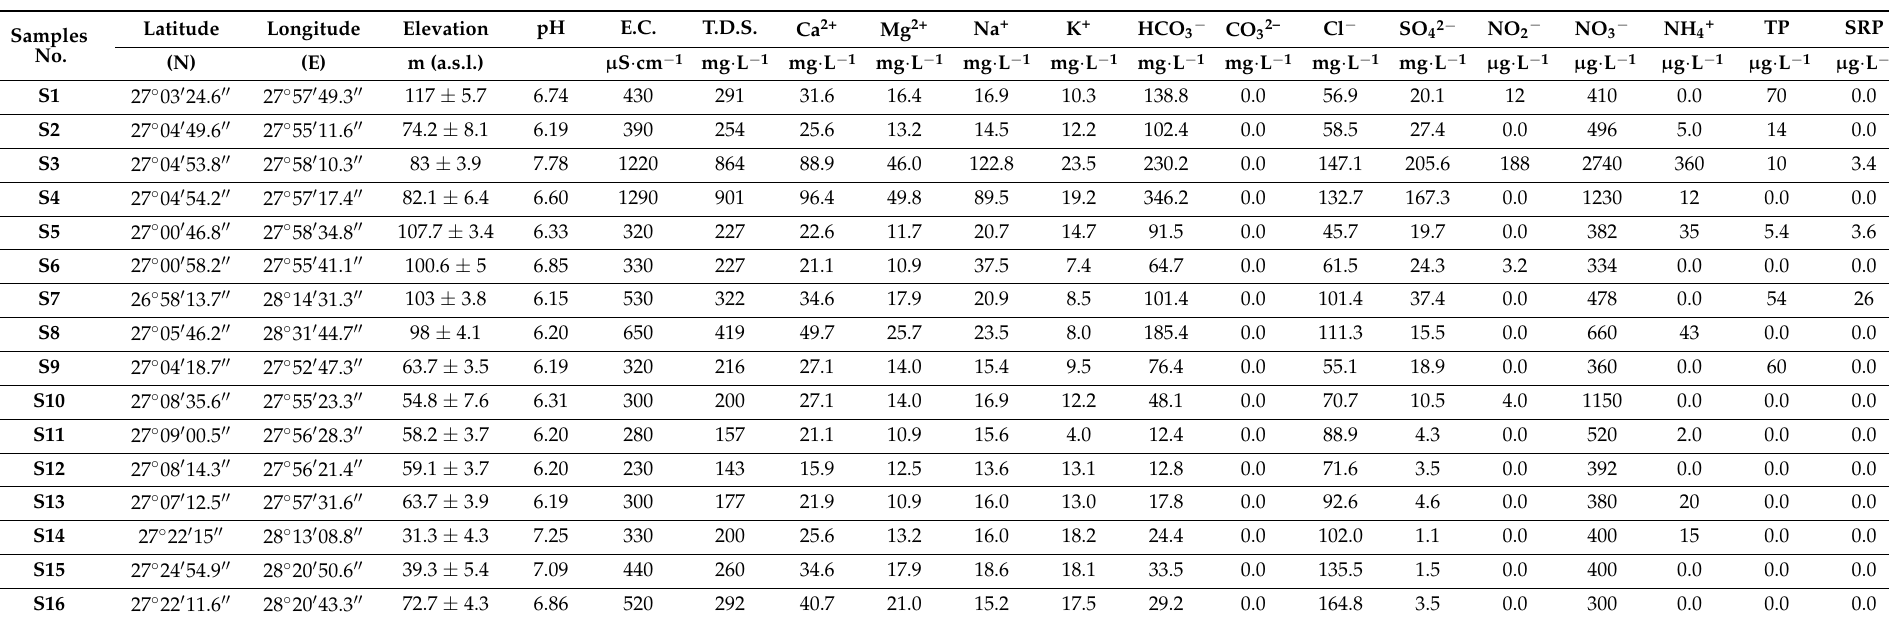
Table 1. Values of physico-chemical parameters for the springs and drilled wells studied in the El-Farafra Oasis. Samples